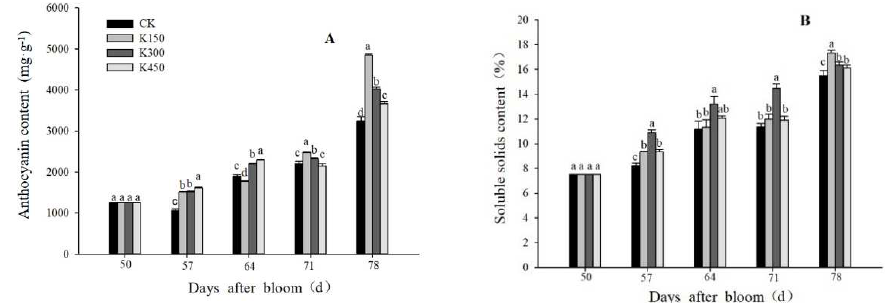
Figure 1. ( A ): Anthocyanin content in skin. ( B ): Soluble solids content in flesh. Different lowercase letters indicate significant differences among the treatments (Duncan’s Multiple Range Test, p < 0.05).